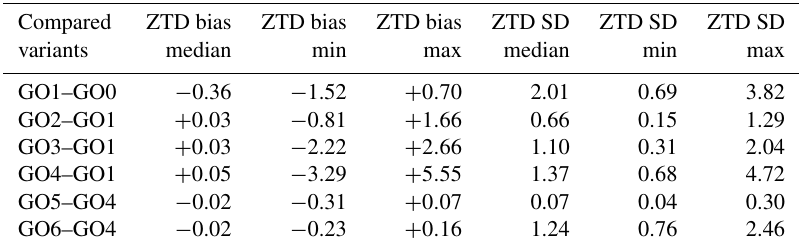
Table 5. Median, minimum (min) and maximum (max) values of total ZTD biases and standard deviation (SD) over all stations. Units are millimetres. Compared ZTD bias ZTD bias ZTD bias ZTD SD ZTD SD ZTD SD variants median